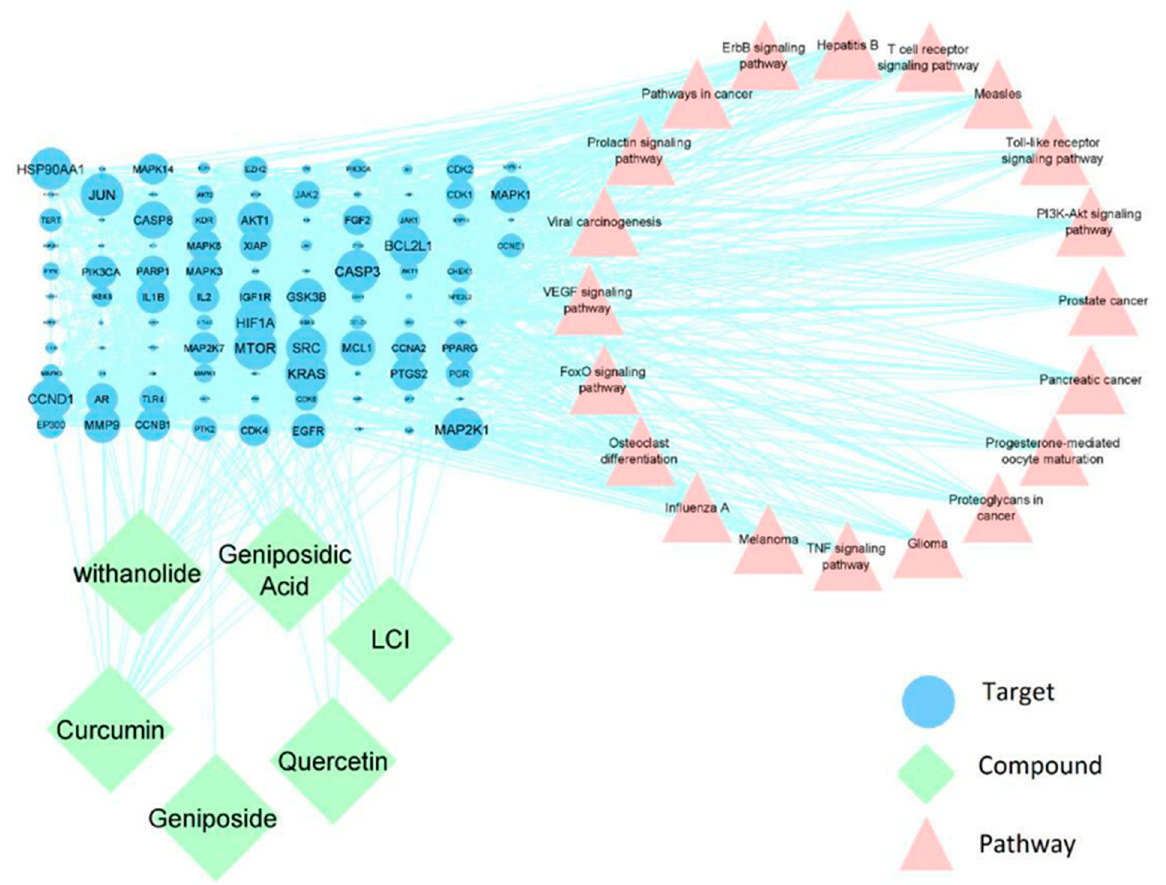
Figure 11. The pathways for the selected compounds with the target genes. The illustration describes the promising target gene-triggered pathway networks for the selected ligands. These pathways are vital in originating tumor, tumor cell growth, differentiation, and promoting tumor cell progression.